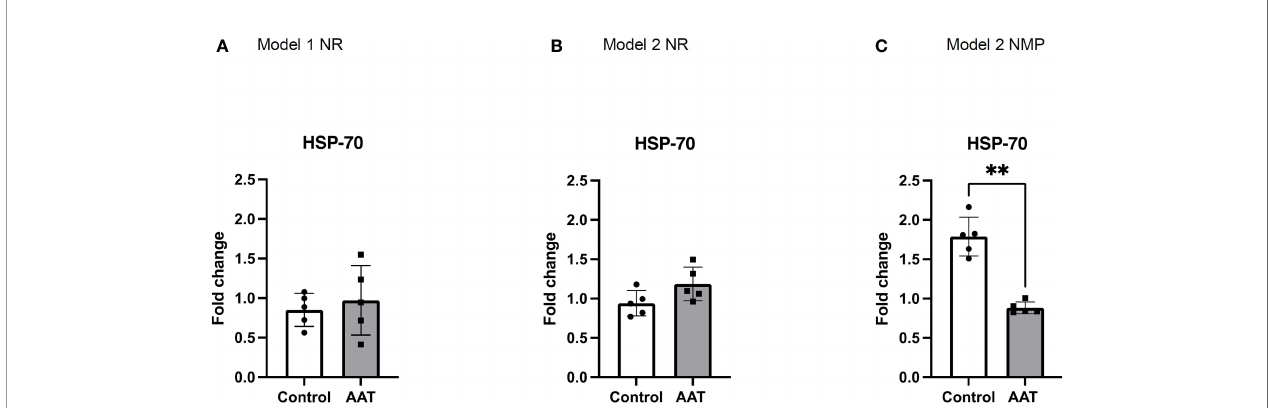
FIGURE 3 | Fold changes of heat shock protein-70 KDa (HSP-70) protein expression in tissue biopsies in normothermic reperfusion (NR) phase following 7-h static cold storage (SCS) in model 1 (A) and following 4-h SCS + 3-h normothermic machine perfusion preservation (NMP) in model 2 (B) as well as in NMP phase in model 2 (C) . Values for HSP-70 were normalised to b actin, and results were normalised to baseline values to calculate fold changes of HSP-70 at the end of NR and NMP. Results are shown as mean ± SD and **p <